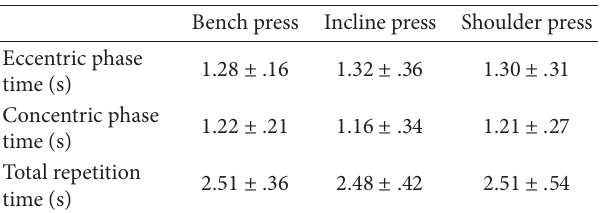
Table 2: Mean ± standard deviation for the three time-related variables across all subjects ( 𝑛 = 24 ). There were no significant differences between the dumbbell press